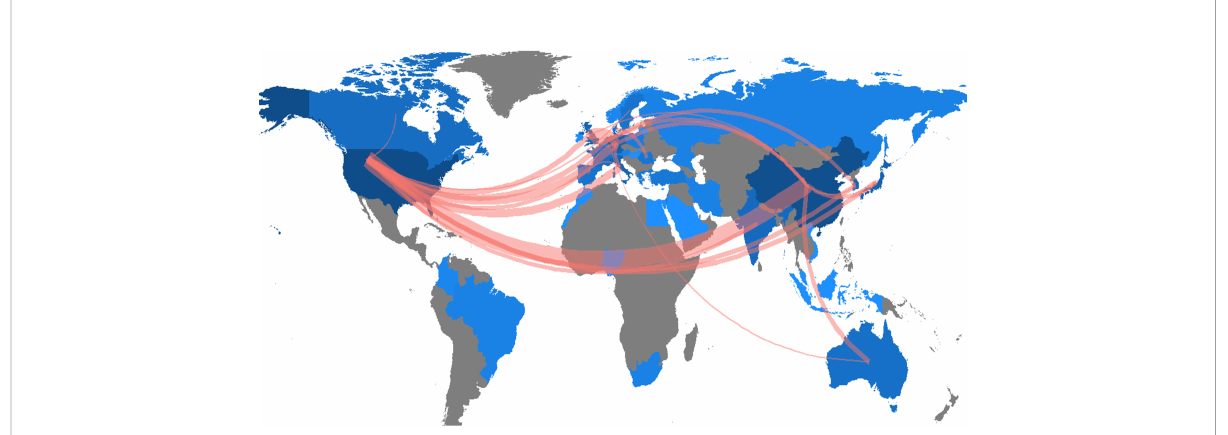
FIGURE 3 Country/region collaboration map. The Darker blues indicated higher collaboration rates, the wider the link line, the higher the rate of collaboration between the two countries. Countries with more than three shared papers were shown by